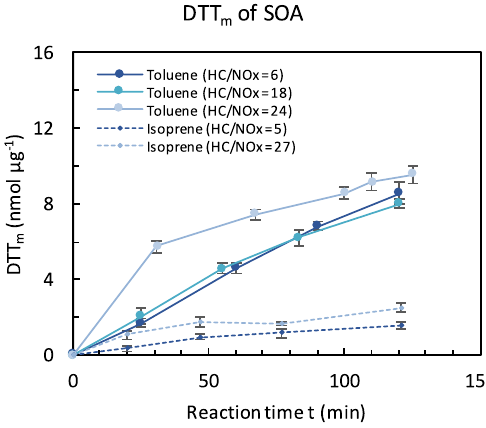
were also compared with those reported in previous studies.